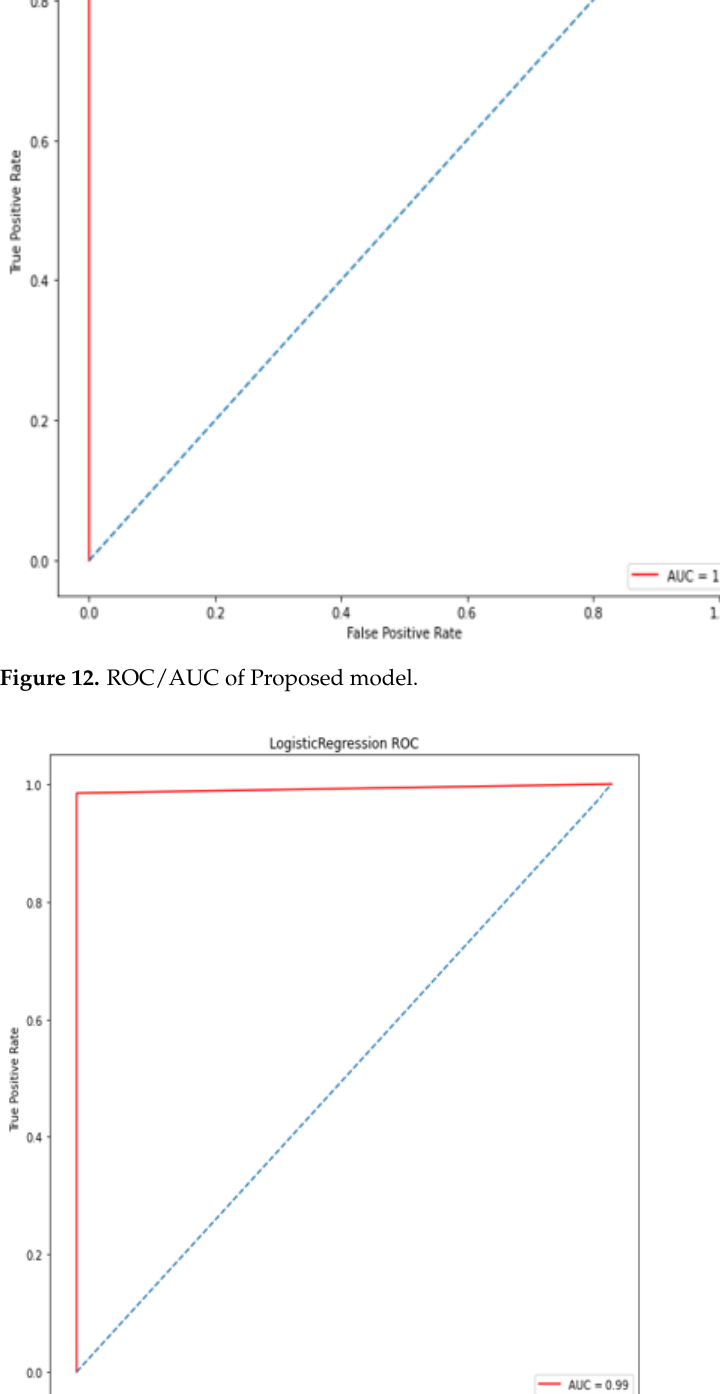
Figure 14. ROC/AUC of Decision tree.